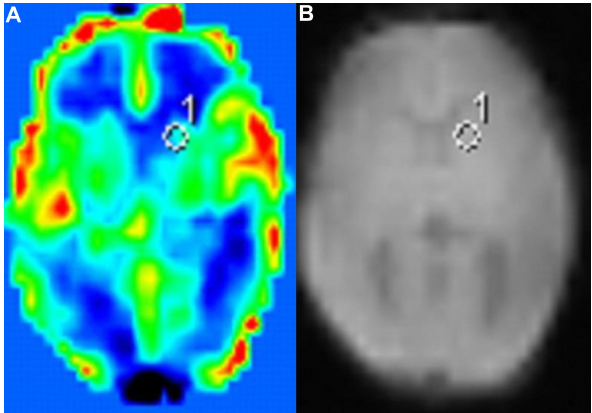
Fig. 1. ASL perfusion-weighted imaging of a control neonate. (A) CBF image. (B)ThelabelsourceASLimage. Thecircledareaindicatestheregion of interest (ROI) at the left caudate nucleus head